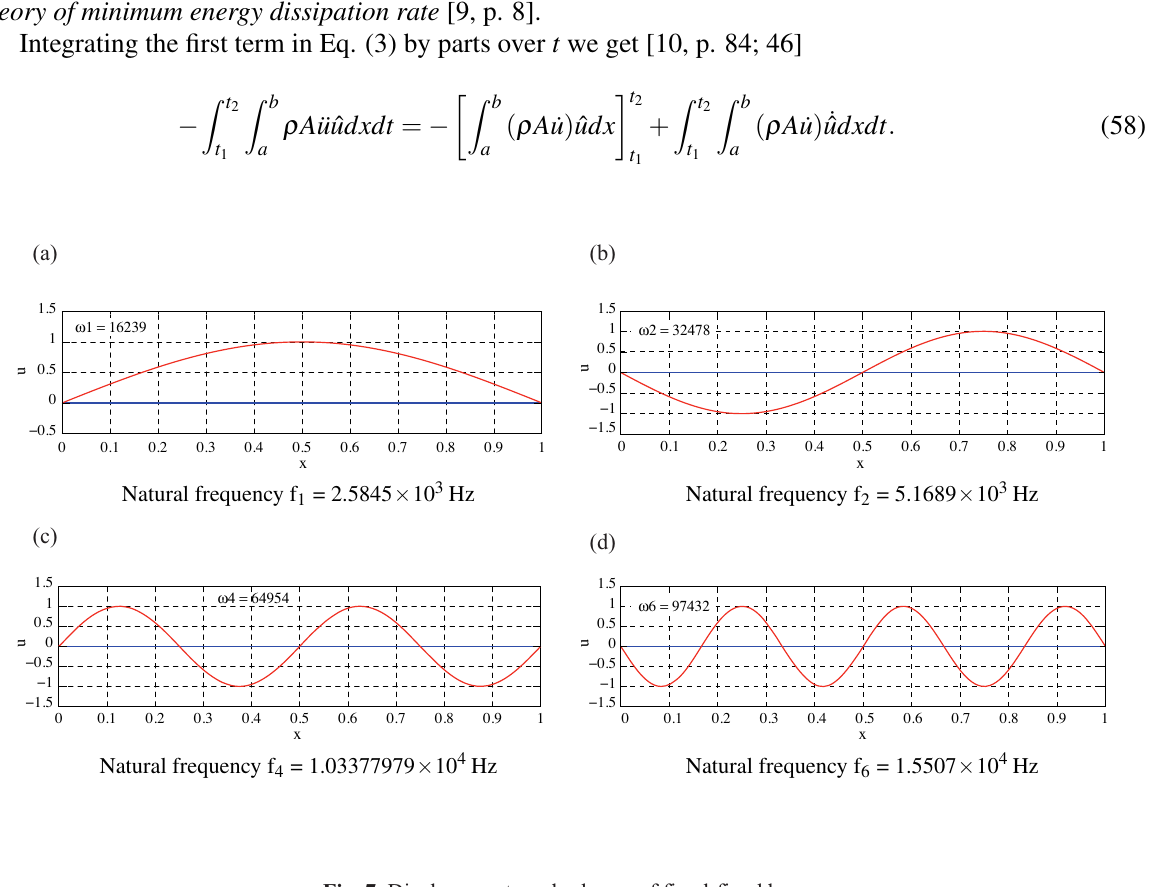
Fig. 7. Displacement mode shapes of fixed-fixed bar.